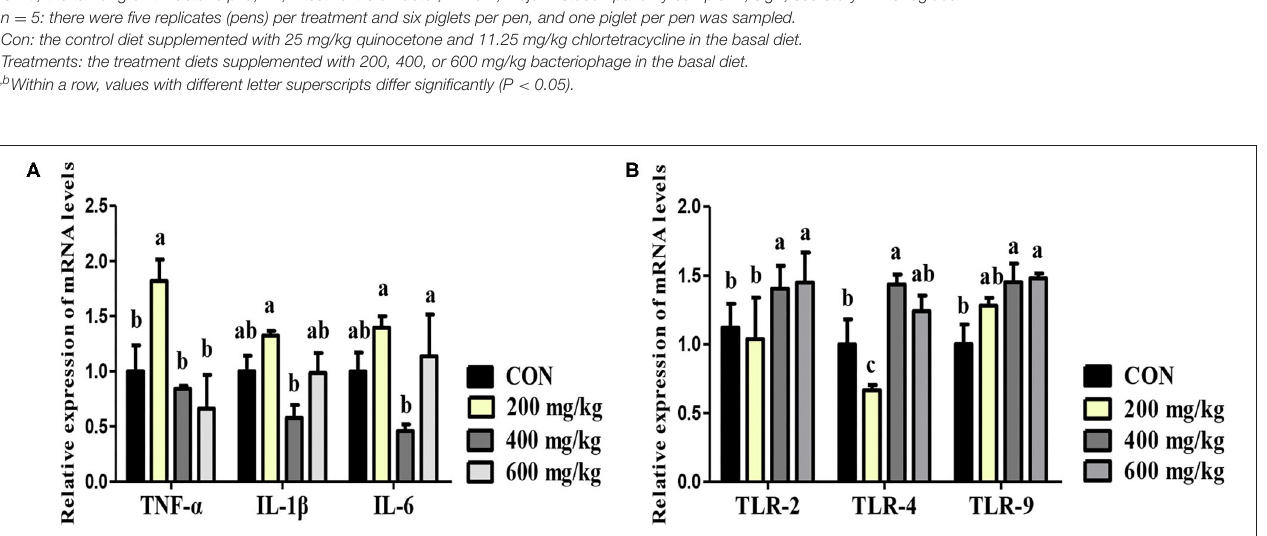
FIGURE 2 | Effects of dietary bacteriophage supplementation on the relative mRNA expression of inflammatory factors (A) and TLRs (B) in jejunal mucosa of weaned piglets fed antibiotic-free diet ( n = 5). TNF- α , tumor necrosis factor- α ; IL-1 β , interleukin-1 β ; IL-6, interleukin-6; TLR-2, toll like receptor-2; TLR-4, toll like receptor-4; TLR-9, toll like receptor-9. Con: the control diet supplemented with 25 mg/kg quinocetone and 11.25 mg/kg chlortetracycline in the basal diet; Treatments (200, 400, and 600 mg/kg): the treatment diets supplemented with 200, 400, or 600 mg/kg bacteriophage in the basal diet; a,b Different letters above bars indicates significant differences ( P <